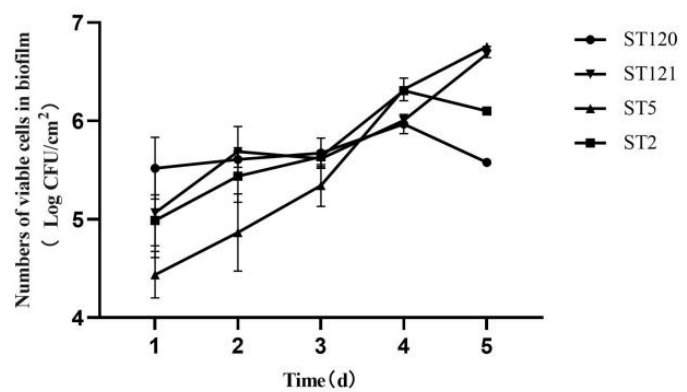
Figure 2. Trends of biofilm formation of four ST isolates during five days. Round represents ST120, upside down triangle represents ST121, triangle represents ST5, and square represents ST2.